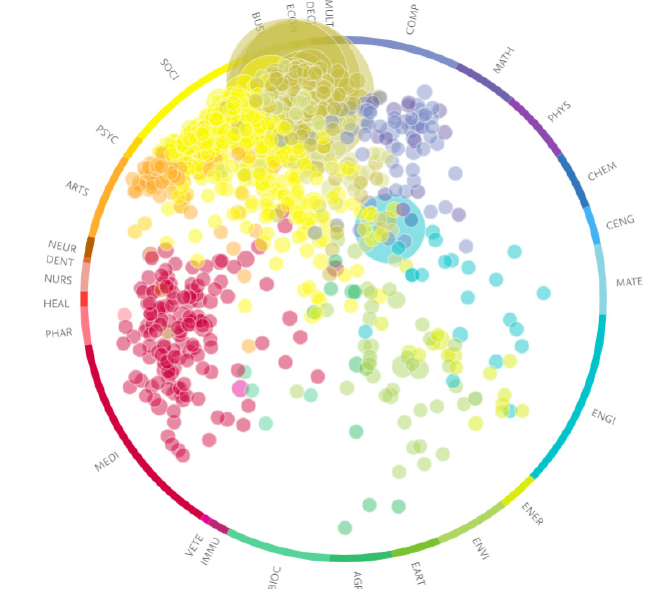
Figure 12. Top 100 topics and thematic clusters in each research area by “blockchain” AND “accounting”